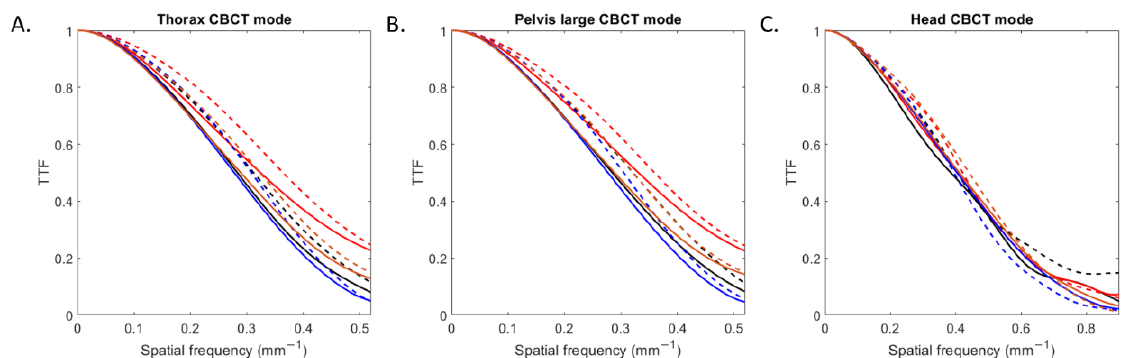
Figure 3. Task-based transfer function (TTF) curves of four inserts obtained with filtered-back projection and iterative reconstruction for the three CBCT acquisition modes.